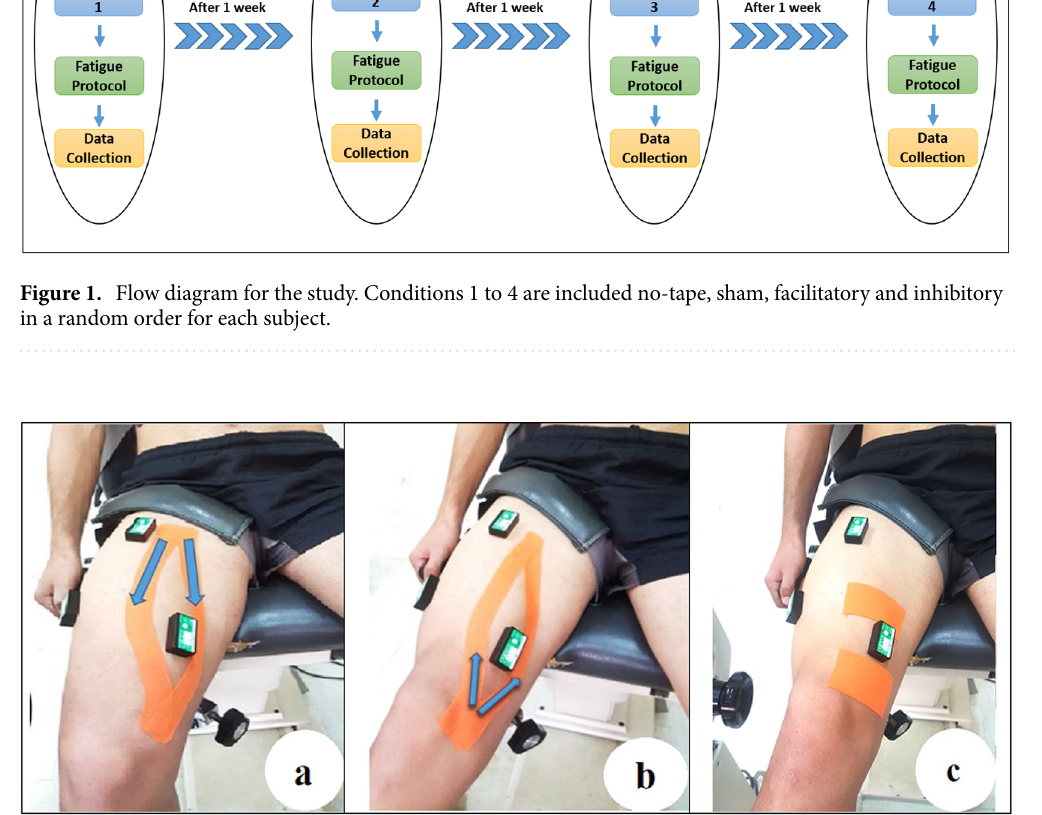
Figure 2. Illustration of the taping techniques. ( a ) facilitating, ( b ) inhibitory, ( c ) sham Kinesio tapings of the Vastus Medialis muscle